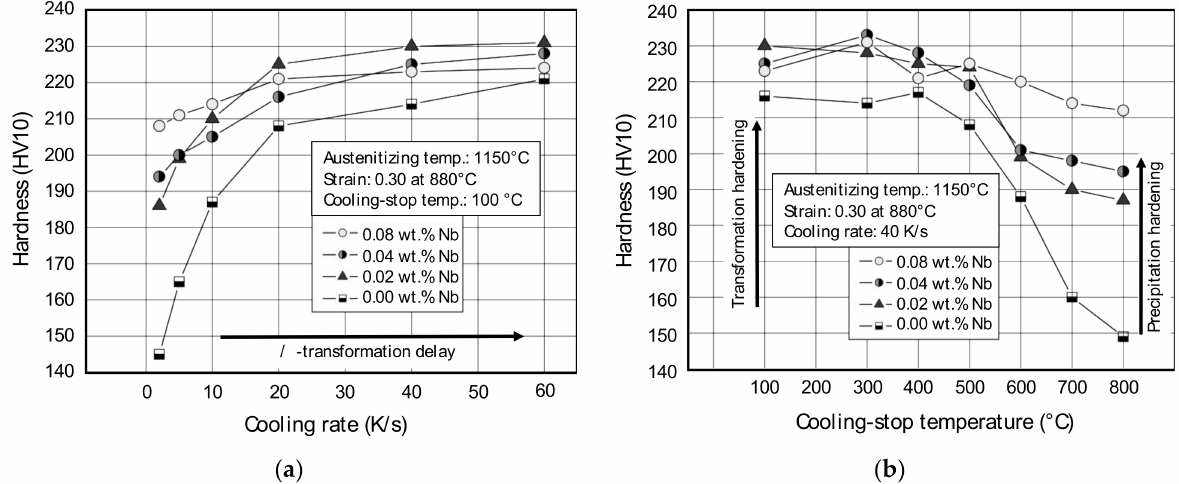
Figure 12: ( a ) Effect of cooling rate and ( b ) cooling ‐ stop temperature on the hardness of TMCP rolled Figure 12. ( a ) Effect of cooling rate and ( b ) cooling-stop temperature on the hardness of TMCP rolled 0.03 wt.% C–1.5 wt.% Mn steel with varying Nb micro ‐ alloy content. 0.03 wt.% C–1.5 wt.% Mn steel with varying Nb micro-alloy content.